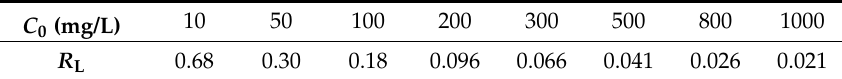
Table 2. Langmuir and Freundlich models’ parameters for removing Pb(II) with MMMT@Zn-BDC. Langmuir Isotherm Freundlich Isotherm T (K) q m (mg/g) b (L/mg) R 2 K F n R 2 298.2 724.64 0.047 0.9850 110.07 3.03 0.9239 Table 3. R L for Pb(II) removal by MMMT@Zn-BDC. C 0 (mg/L) 10 50 100 200 300 500 800 1000 R L 0.68 0.30 0.18 0.096